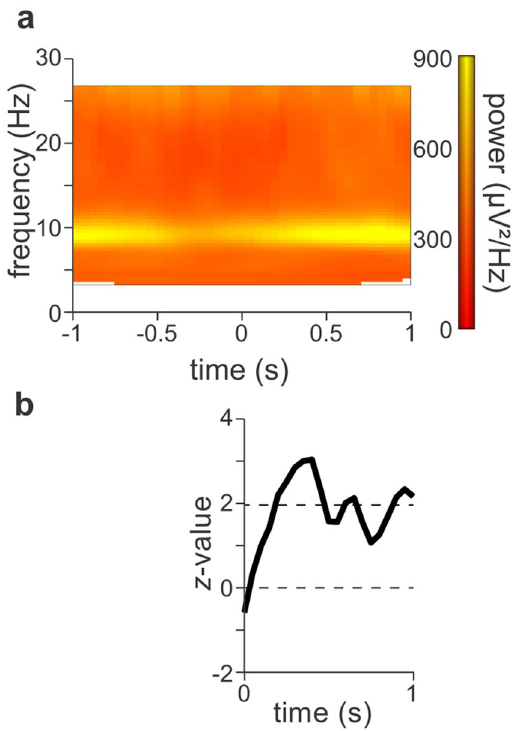
Figure 4. Alpha power predicts the fate of the subsequent perceptual duration right after the emergence of a percept. ( a ) TFR of the time window around the button press, averaged over the 14 parietal and occipital electrodes indicated in Fig. 2b. Alpha power decreases just before the perceptual reversal and increases thereafter (see Fig. S1 for a precise time course of alpha power only). ( b ) Alpha power after the onset of an individual perceptual representation was predictive of its subsequent duration, quantified by the z -values computed on a 500 ms long sliding window in the interval between 0 s and 1 s. The dotted line at 1.96 indicates the z -value threshold at p -value =